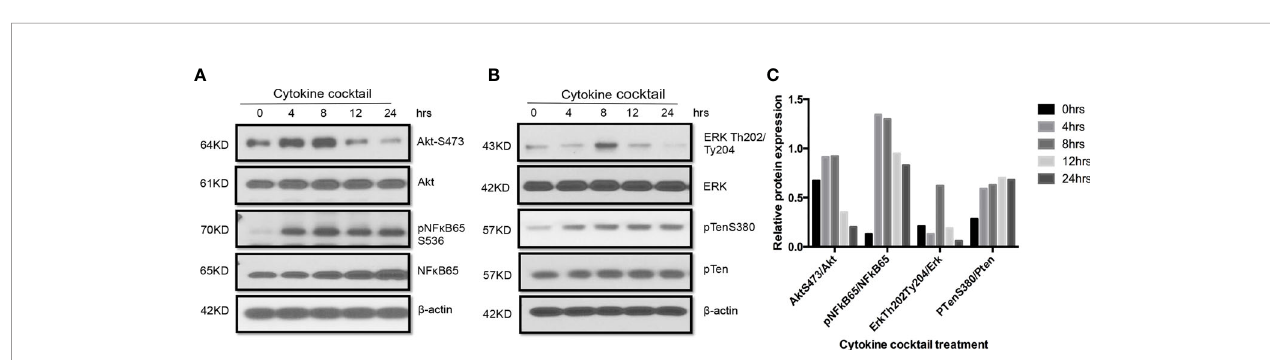
FIGURE 5 | Activation of multiple signaling pathways in TEC challenged by cytokines. Primary human renal TECs were treated with the cytokine cocktail. (A, B) Western blot of PI3K – Akt pathway, NFkb pathway, and Erk signaling pathway in cells treated with cytokine cocktail. (C) Densitometric quantitation of AktS473, pNFkB65, ErkTh202/Ty204, and pTenS380. All Western blots are representative of two independent